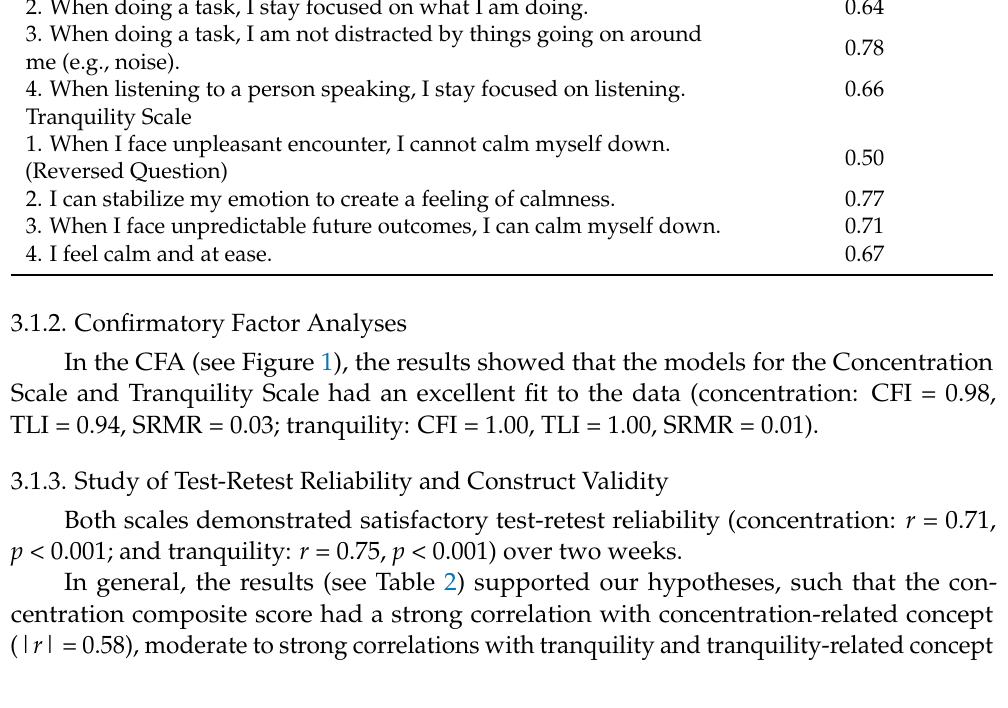
Table 1. Factor loadings of the final Concentration Scale and final Tranquility Scale. Items Factor Loadings Concentration